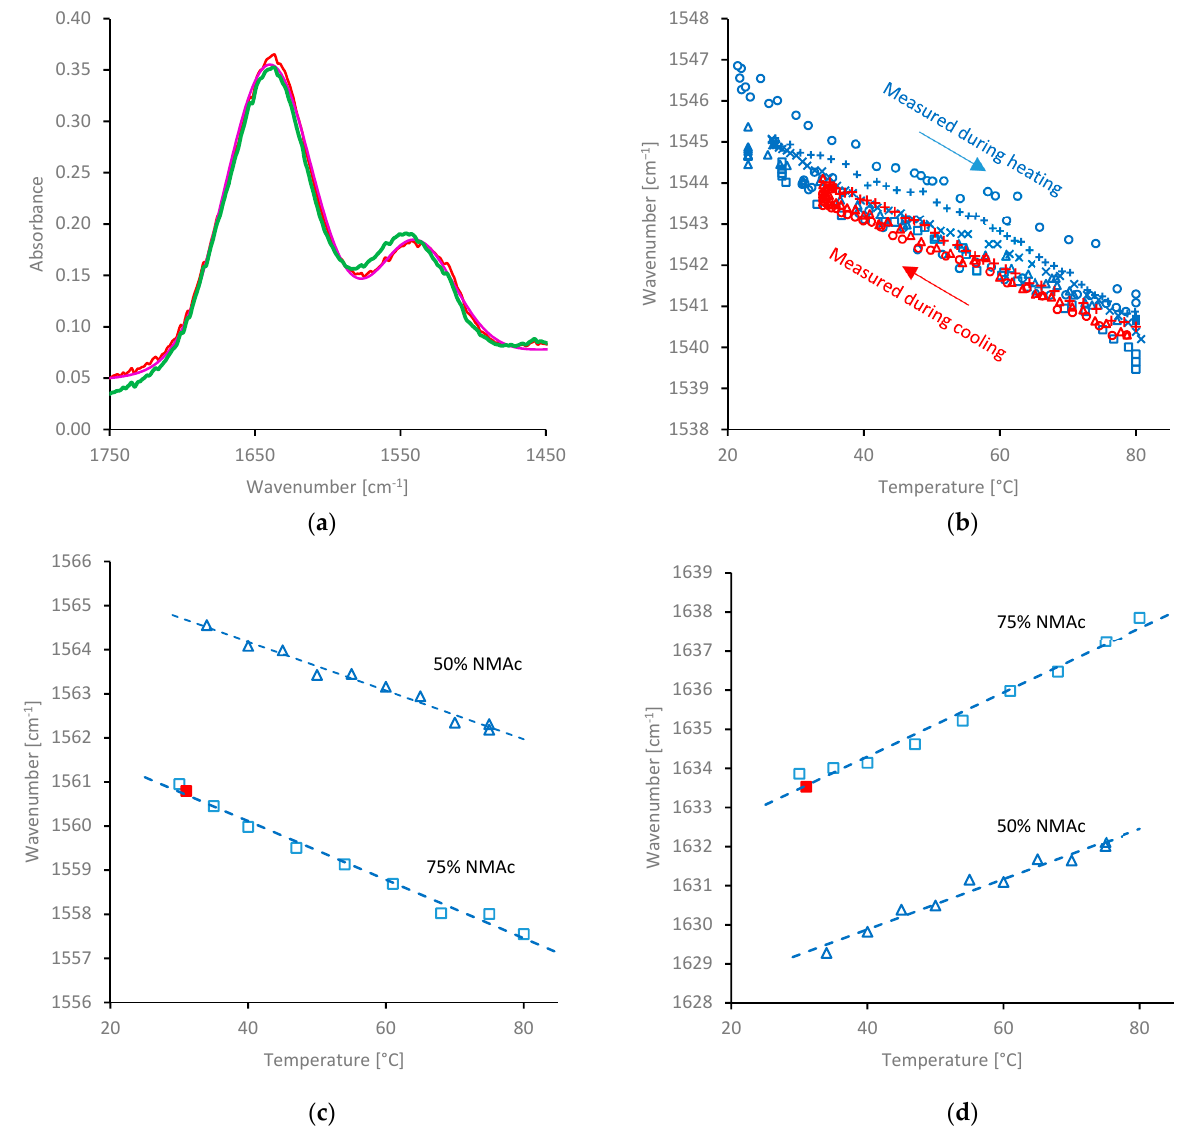
Figure 5. Effect of temperature on the IR spectra of NSF and NMAc: ( a ) amide I and II region for NSF measured at 27 (green) and 81 °C (red), with a Gaussian model fitted to the 81 °C data (magenta); ( b ) plot of amide II peak position vs. temperature for NSF; the different symbols represent different NSF specimens, blue points were measured during heating from room temperature, red points were measured during cooling from 81 °C; ( c ): amide II and ( d ) amide I peak positions for 50 and 75% w / w aqueous NMAc solution; blue open points were measured during heating, the red filled points were measured after subsequent cooling of the 75% NMAc solution.